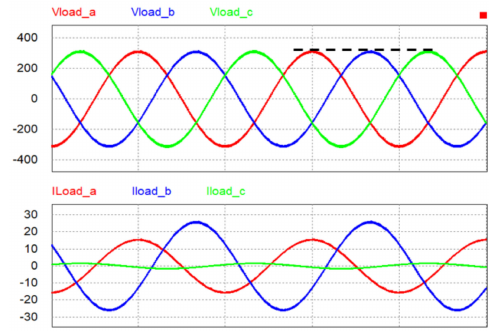
Figure 13. Simulation results of the PI + R controller.